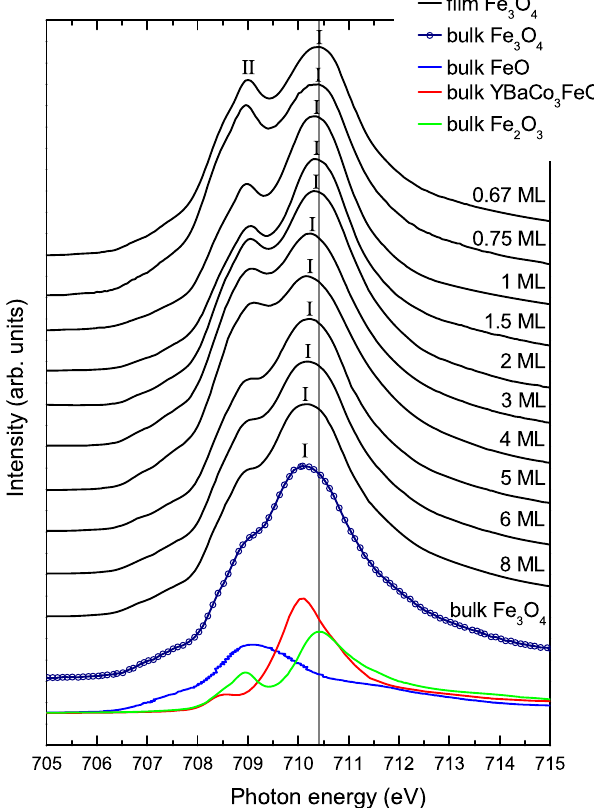
FIG. 2. Fe L 3 XAS spectra of Fe 3 O 4 films. The film thickness varies from 0.67 to 8 ML. The reference spectra of bulk Fe 3 O 4 , bulk YBaCo 3 FeO 7 (Fe 3 þ in tetrahedral coordination) [28], bulk FeO (Fe 2 þ in octahedral coordination) [32], and bulk Fe 2 O 3 (Fe 3 þ in octahedral coordination) are also included. All spectra were measured at 300 K. The gray line indicates the energy position of the main peak in the spectrum of bulk Fe 2 O 3 . The full Fe L 2 ; 3 spectral range is presented in Ref.